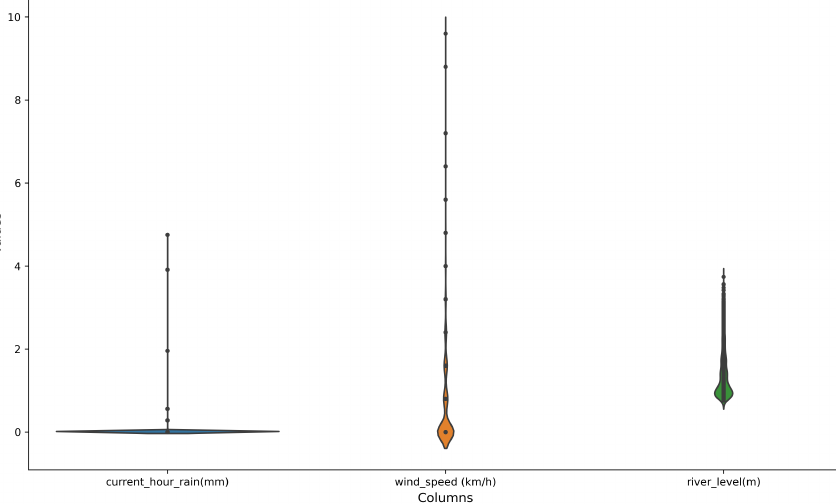
Figure 19. Distribution of some selected continues